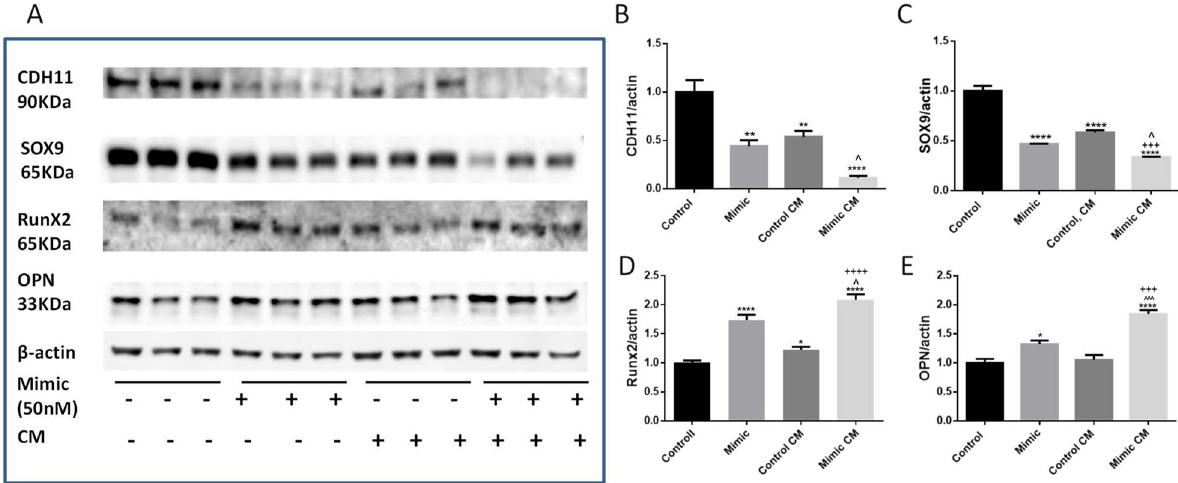
Fig. 5 Mimic of miR-101 downregulated CDH-11 and SOX9 expression and promoted osteogenesis in HAVICs treated by CM after transfection. A Western blot against antibodies of CDH11, SOX9, Runx2, and OPN in HAVICs transfected with miR-101-3p mimic for 48 h and then treated with CM for additional 48 h. β-actin serves as internal loading control. B – E Quantification of CDH11, SOX9, Runx2, and OPN normalized with β-actin. Data means SEM. *p < 0.05, **P < 0.01 and ****P < 0.0001 vs Control; +++ P < 0.001 vs Control, CM; ^P < 0.05 and ^^^P < 0.001 vs Mimic. n = ± repeats